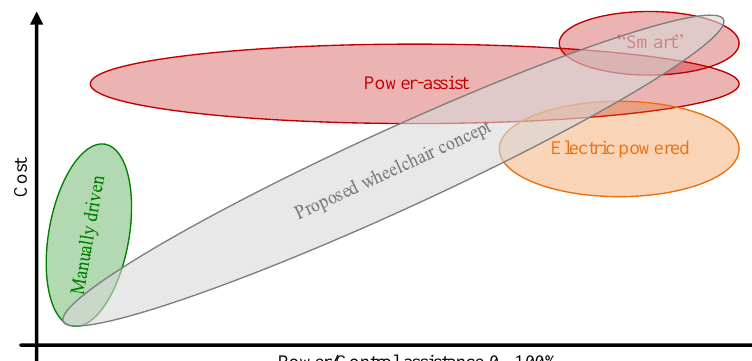
Figure 1. Cost availability of the wheelchairs presently on the